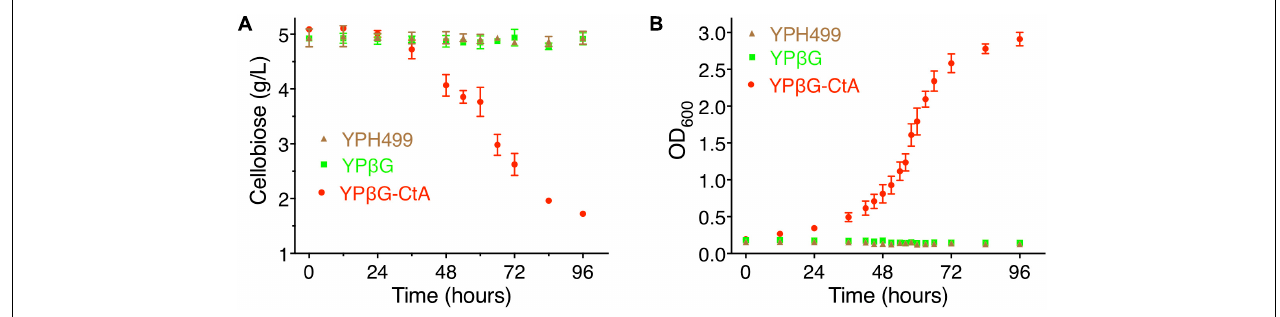
FIGURE 3 | The cellobiose mediated growth of S. cerevisiae strain YPH499, YP β G, and YP β G-CtA. (A) The time course of cellobiose concentration of the YPH499, YP β G, and YP β G-CtA strains in the cultures with 0.5% cellobiose as the sole carbon source. (B) Growth curve of S. cerevisiae strains. The YP β G-CtA strain expressing transporter ctA and bgl consumed cellobiose, while the YPH499 and YP β G strains could not utilize cellobiose.